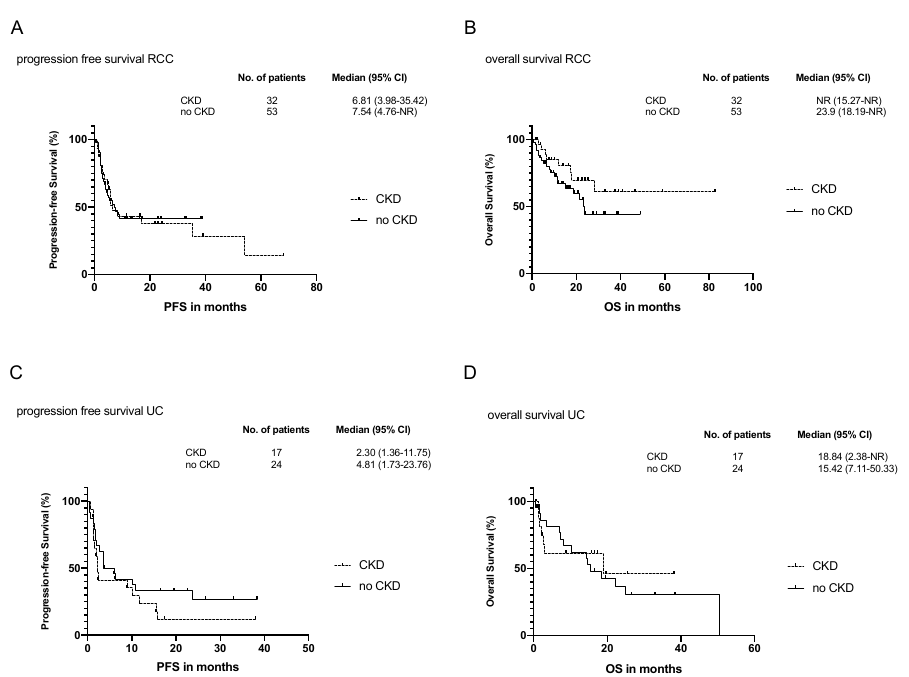
Figure 1. ( A ) Progression-free survival (PFS) of patients with RCC and CKD or without CKD (non-CKD). The percentage of patients without tumor progression is plotted as unadjusted PFS. Median PFS and 95% confidence intervals (95%CI) are given in months. Hazard ratio (HR) with 95%CI and statistical differences between CKD and non-CKD group as result of a multivariate Cox regression analysis are indicated. ( B ) Overall survival (OS) of patients with RCC and CKD or without CKD (non-CKD). The percentage of patients alive is plotted as unadjusted OS. Median OS and 95% confidence intervals (95%CI) are given in months. HR with 95%CI and statistical differences between CKD and non-CKD group as result of a multivariate Cox regression analysis are indicated. ( C ) Same as in ( A ) but for patients with UC. ( D ) Same as in ( B ) but for patients with UC.